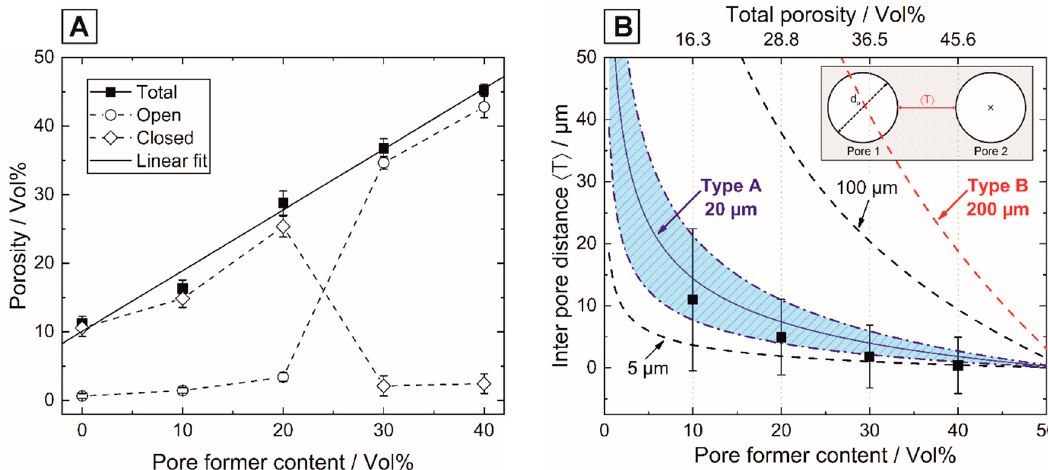
Figure 2. Porosity fractions (total, open and closed) of the porous hydroxyapatite (Hap) samples in dependence of the pore former content containing 20 µm spherical pore formers ( A ): The linear fit of ( A ) shows the linear relation (continuous line) between the total porosity and the pore former content, the dashed lines are only a guidance for the eye. ( B ) shows the dependence of the real surface-to- surface inter pore distance (data points represented by square symbols), determined by image analysis from SEM-micrographs, on the pore former content for the 20 µm spherical pore formers. The experimental data was compared to the model of Equation (1) inserting the measured particle size distribution of the 20 µm spheres of Figure 1 C (see material and methods, here highlighted in the blue section) and for different pore sizes including 5, 100 and 200 µm (dashed lines).